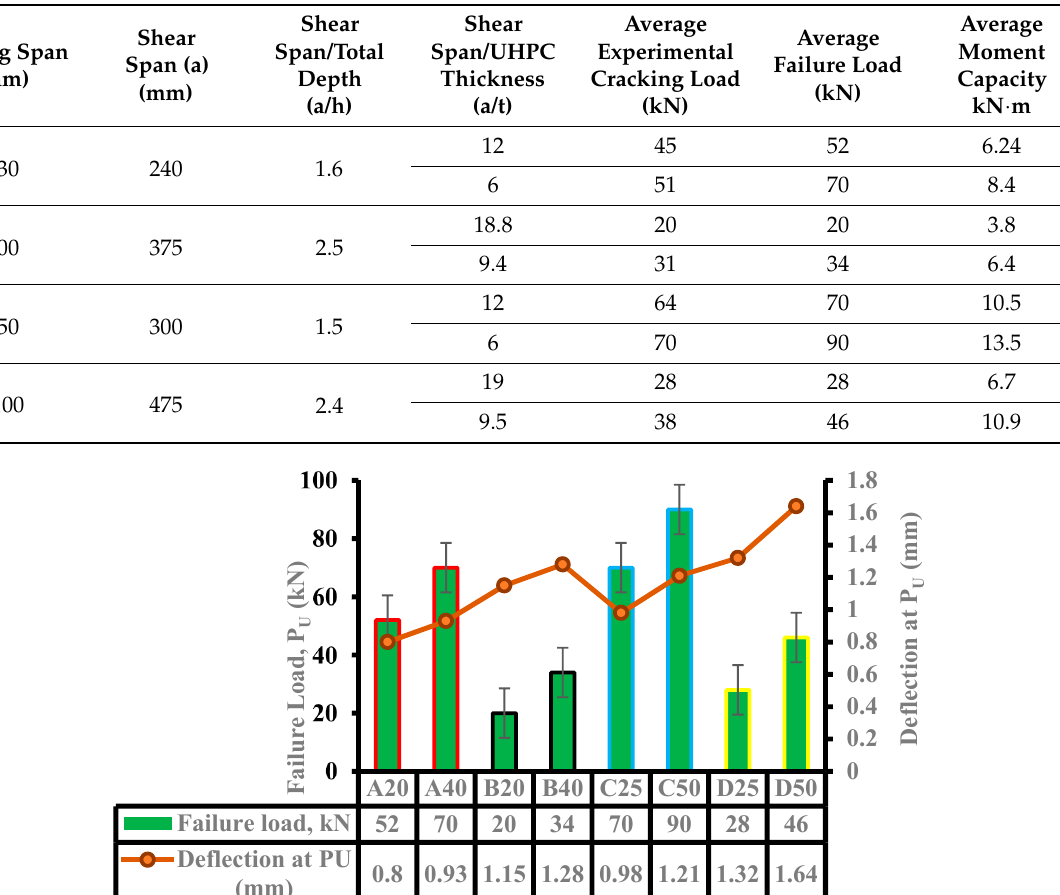
Table 6. Hybrid beams spans, failure load, and moment capacity.